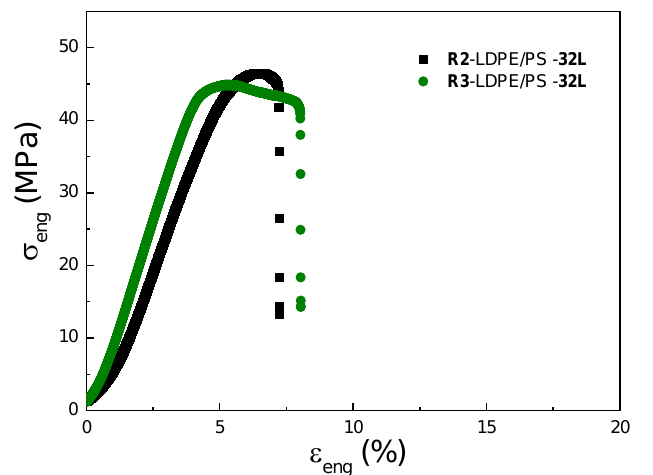
Figure 9. Engineering stress-strain plot of the recycled LDPE/PS (10/90)-32L multilayer films (MD) with the R2 and R3 recycling systems.